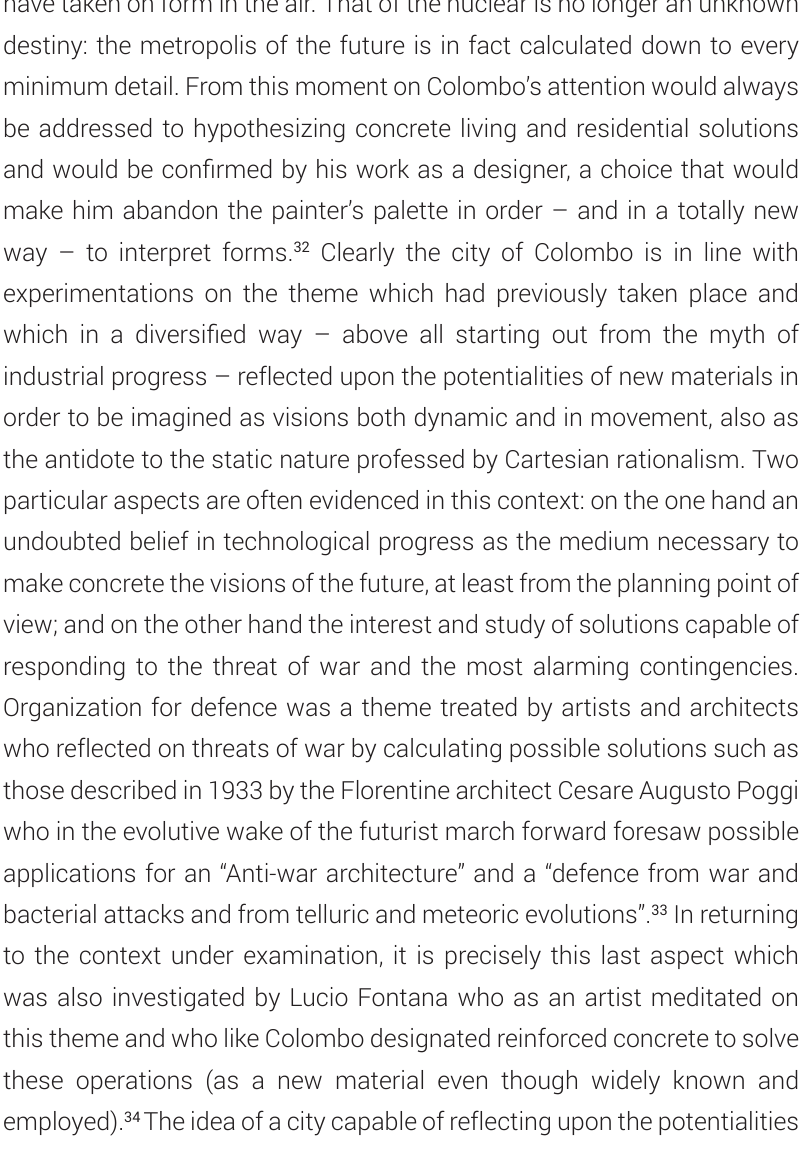
Detail of Calder’s scenography for “Nucléa”, FIG. Paris, Téâtre National Populaire. Published in “Autour de “Nucléa,” Numero , no. 3 (May- June, 1953)